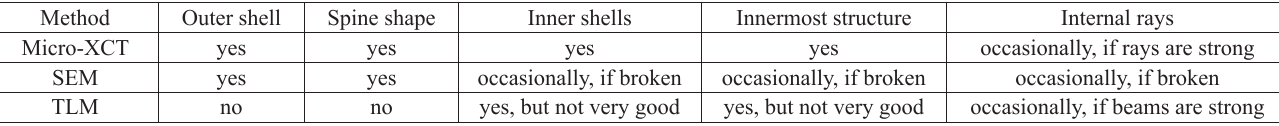
Table 1. Features observed among different photos taken by micro computed tomography (micro-XCT), scanning electron microscopy (SEM), and transmitted light microscopy (TLM).